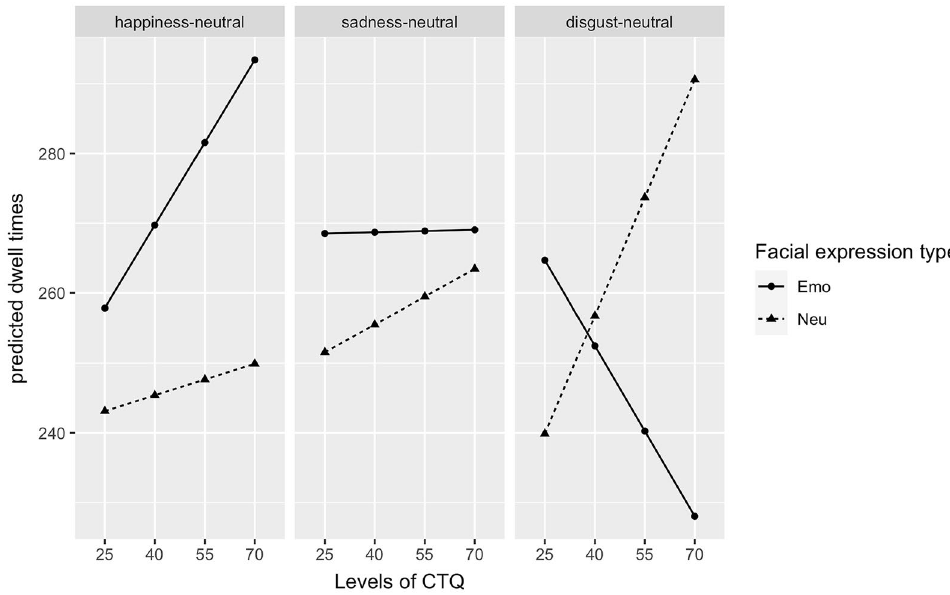
Figure 3. Predicted dwell times on emotional and neutral facial expressions as a function of facial expression pairs and different levels of CTQ.